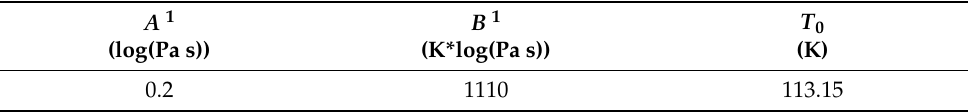
Figure 3. Viscosity ( a ) versus shear rate for different temperatures’ fitting WLF model and ( b ) curve fit for VFT model as a function of temperature for shear rates below 1(1/s). Table 3. VFT parameters for viscosity as function of temperature for shear rates below